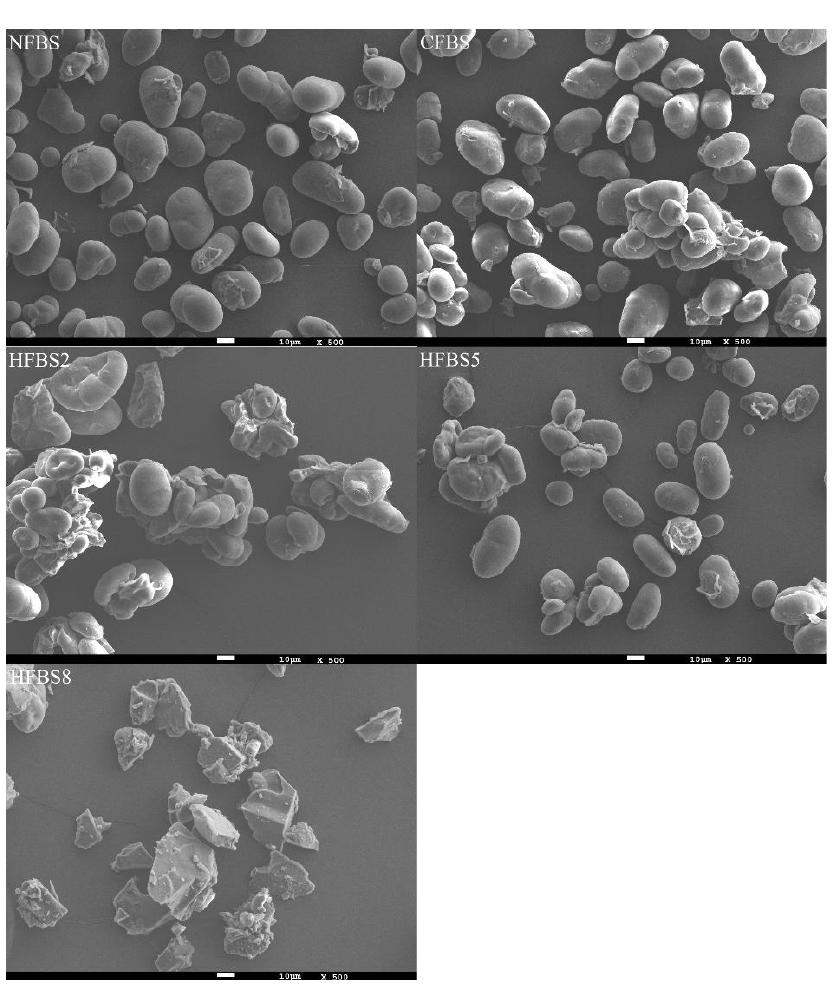
Figure 5. SEM images of native and hydrolyzed faba bean starch. The magnification of images was 500x. NFBS, native faba bean starch; CFBS, conventional hydrolysis faba bean starch; HFBS2, HFBS5, and HFBS8, hydrolyzed faba bean